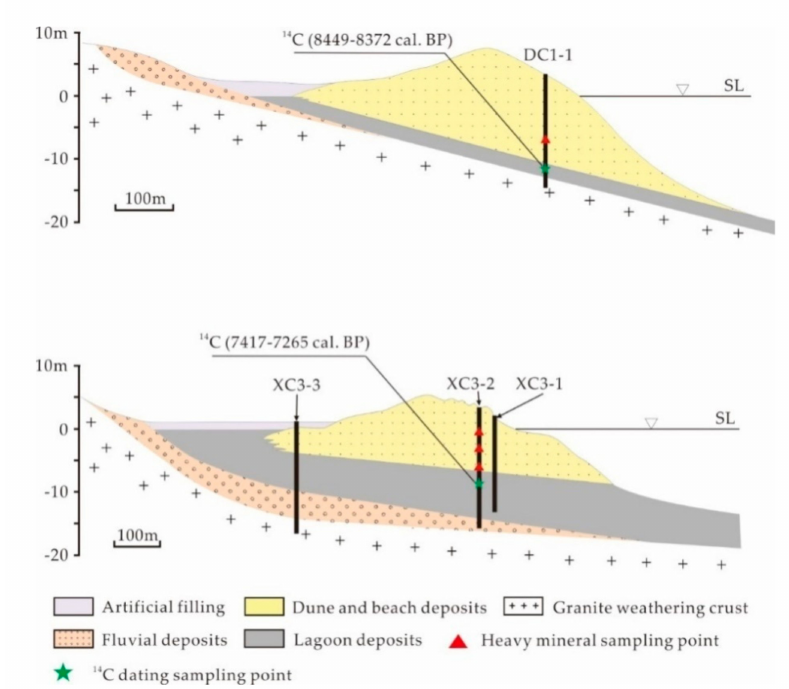
Figure 2. The strata profiles with portholes at Xichong and Dongchong. The red triangle is the sampling point of heavy minerals. The green star is the sampling point of 14 C dating; calibrated age is in